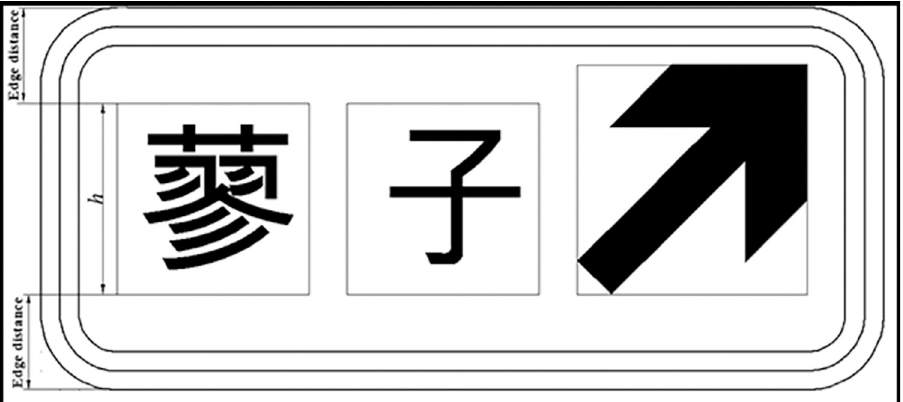
Fig 4. Layout of single-row text type exit advance guide